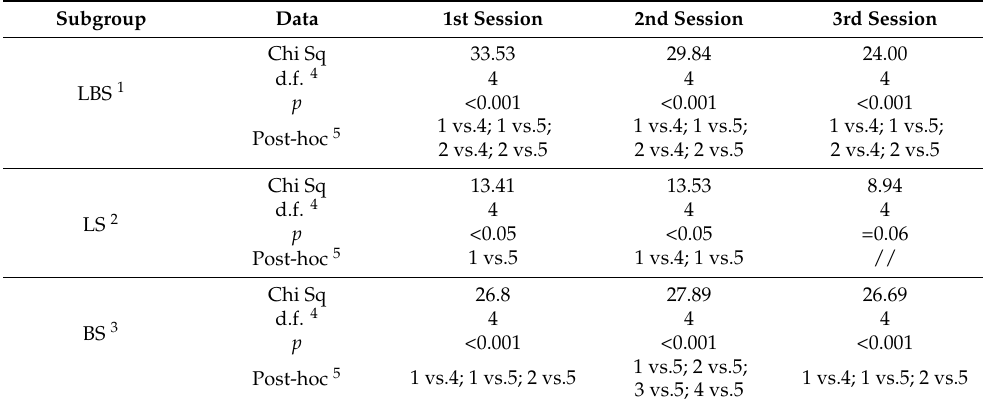
Table 11. Kruskal-Wallis test followed by the Dunn-Bonferroni post-hoc between TGMD-3 scores and grades.